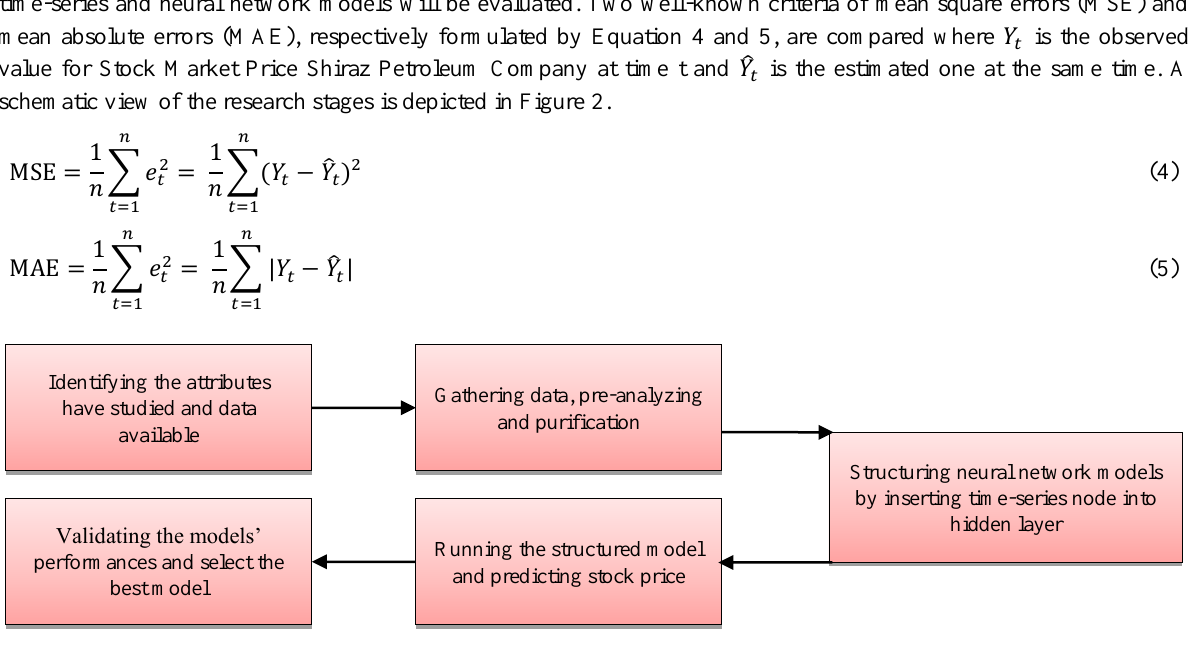
Figure 2. Overall view of the research methodology followed in this